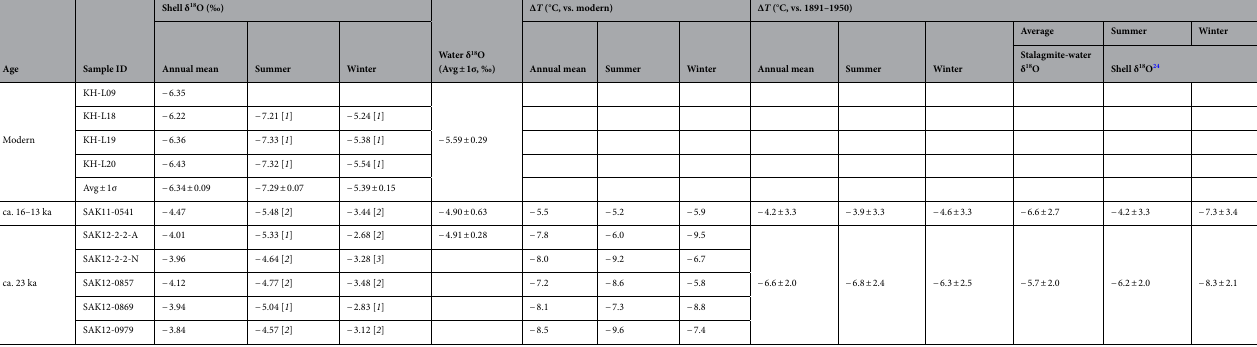
where Δ T represents the temperature difference between the past and present. δ 18 O fossil , δ 18 O inclusion , δ 18 O modern , and δ 18 O spring are the oxygen isotope values of fossil snails, stalagmite fluid inclusion waters, modern snails, and modern spring waters, respectively. Based on the law of propagation of data error, the errors on the temperature reconstruction were estimated from the root-sum-square of the standard deviations of δ 18 O fossil , δ 18 O inclusion , δ 18 O modern , and δ 18 O spring values.